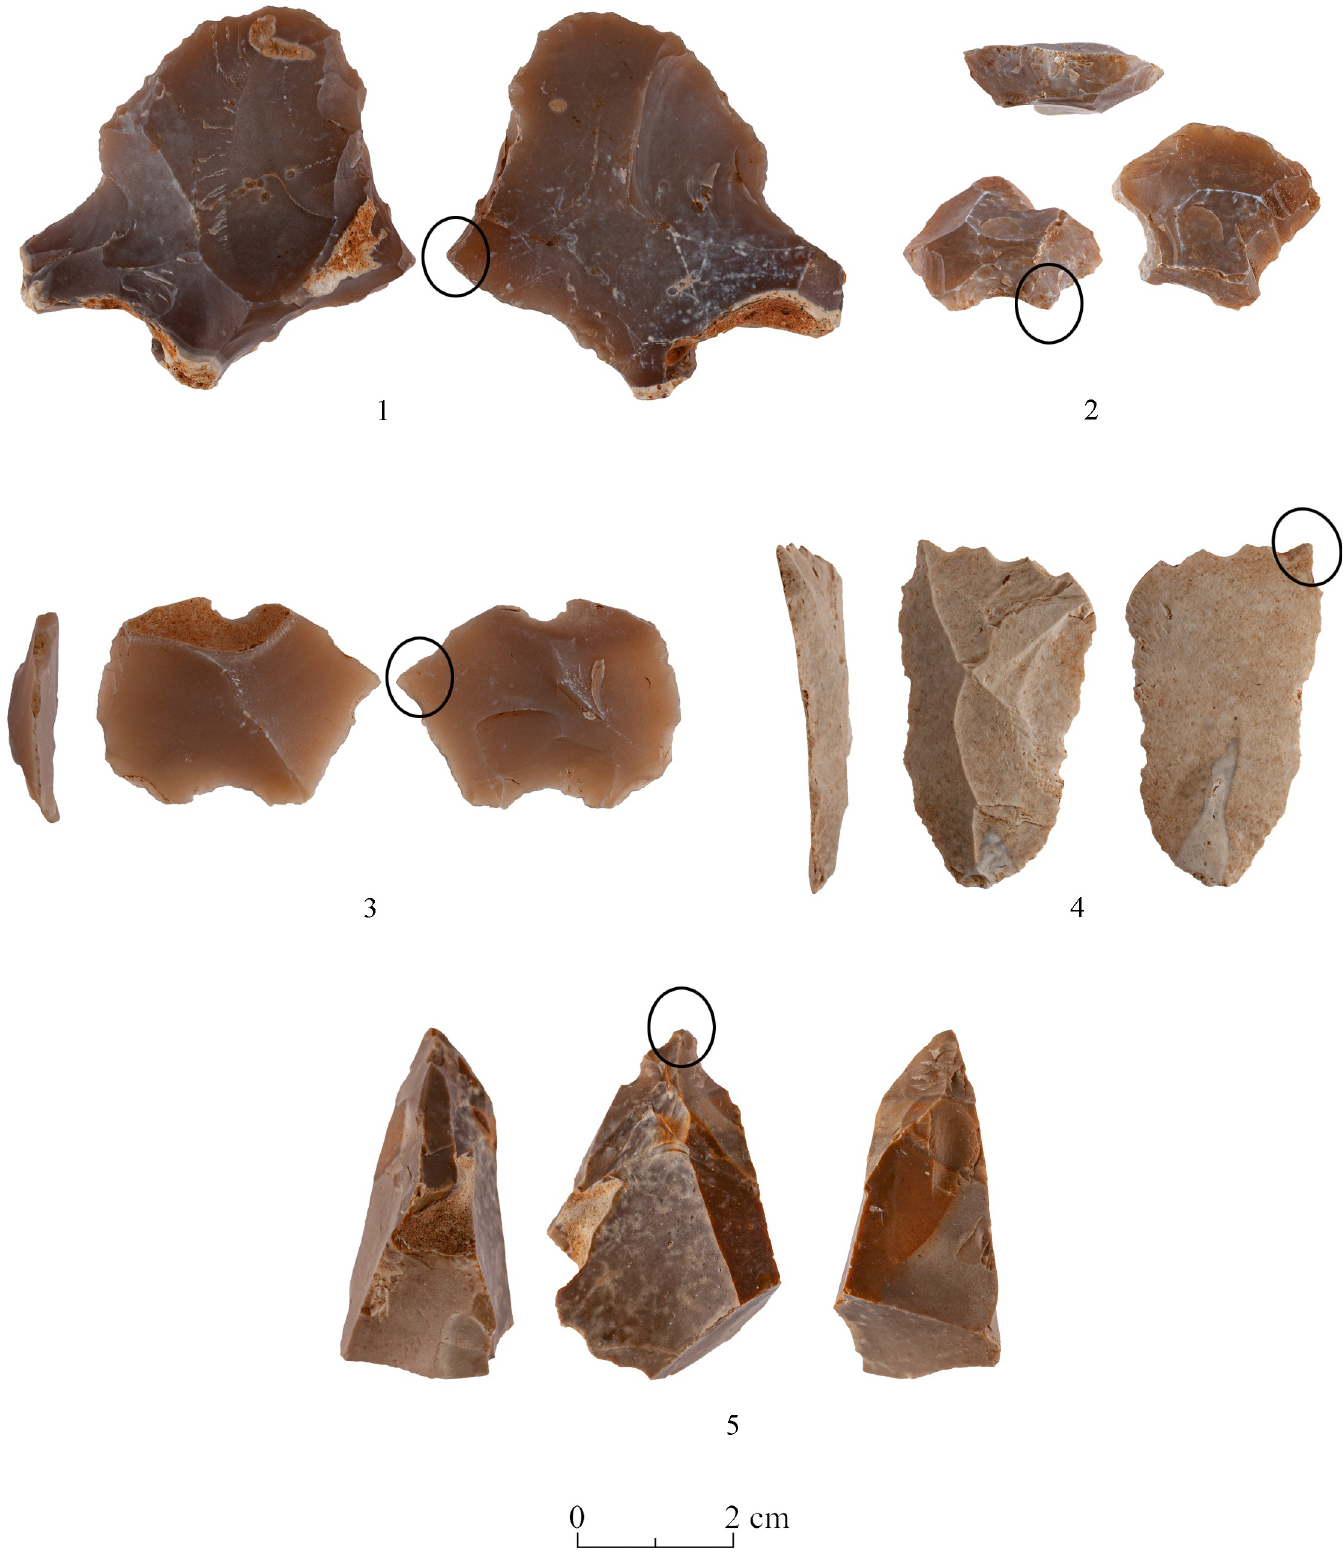
Fig 23. Borers and awls: 1–5.